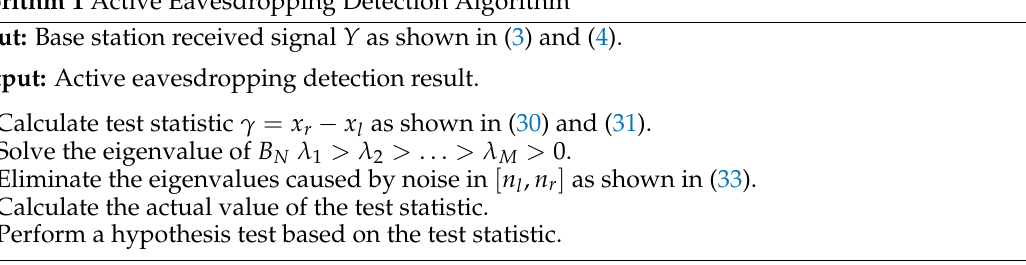
Algorithm 1 Active Eavesdropping Detection Algorithm